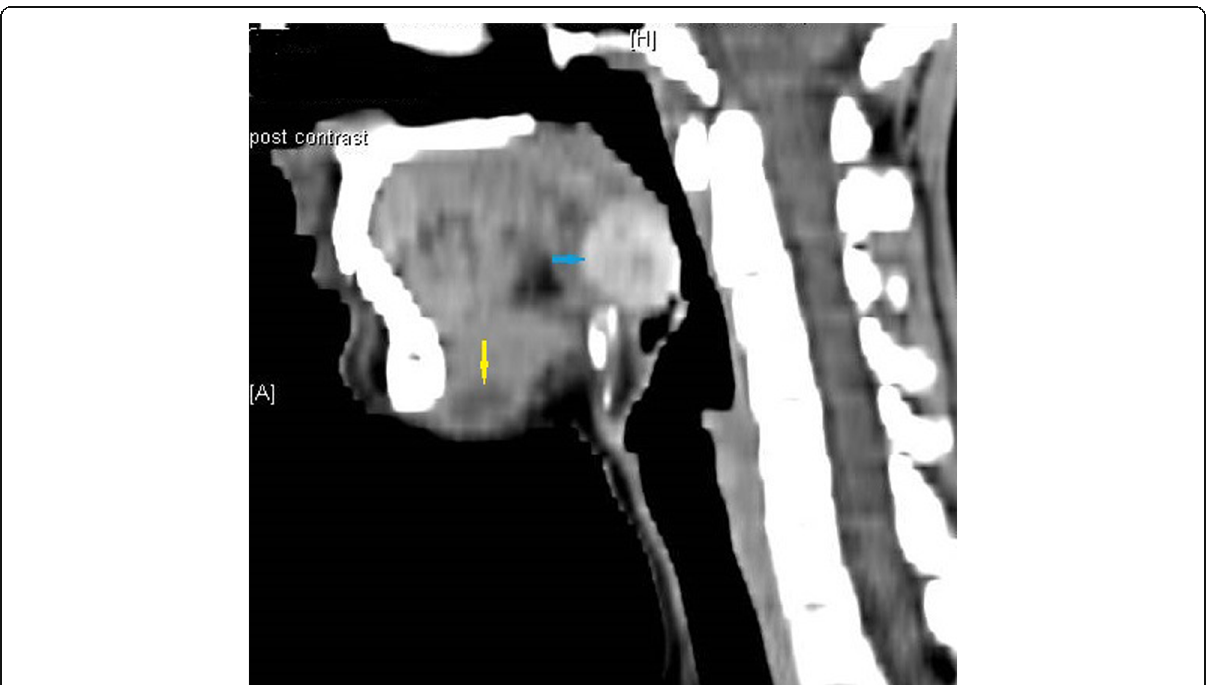
Fig. 2 Sagittal view of contrast-enhanced CT showing lingual thyroid: a well-defined, rounded, mainly hyper-dense soft tissue density at the base of the tongue (blue arrow); submental abscess (yellow